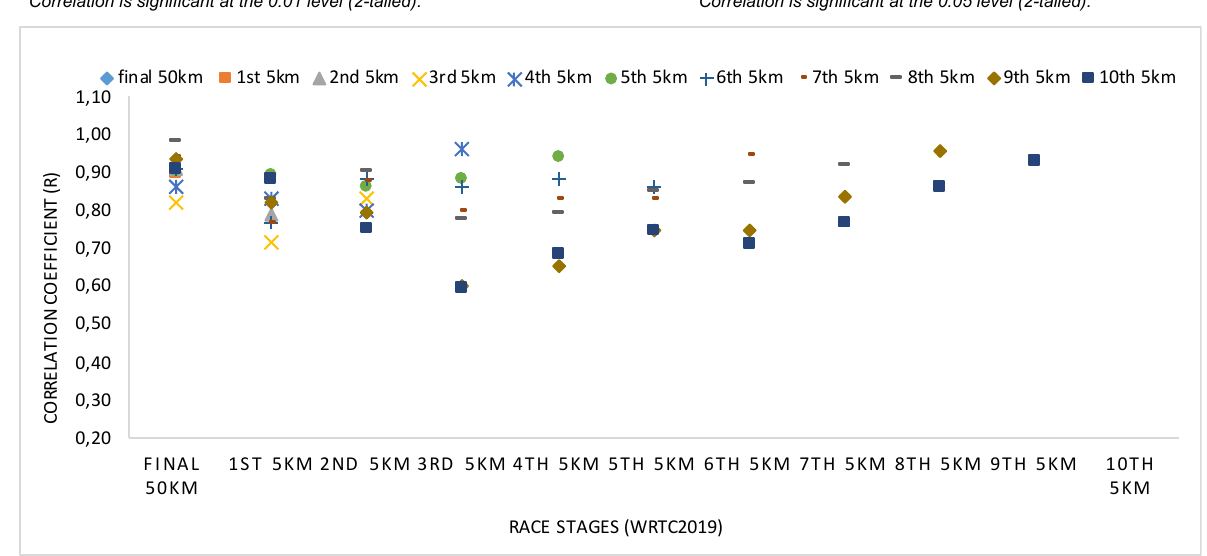
Figure 5 . Correlation coefficients (r) between the performance times averages of the women’s 50km racewalking stages in